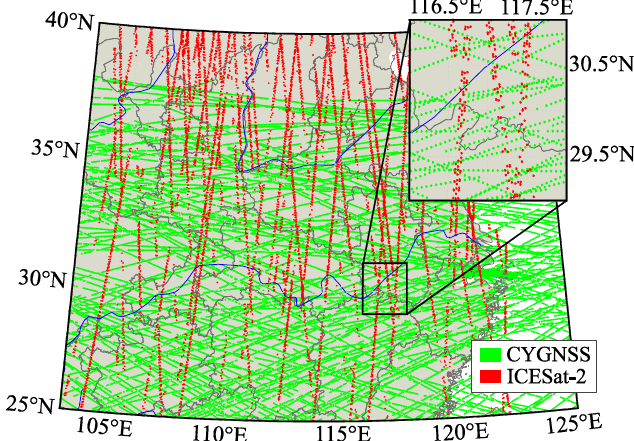
Figure 1. The locations of CYGNSS’s SPs from its eight satellites are plotted in green for 1 April 2019. ICESat-2 data from the whole month of April 2019 is plotted in red. Zoom window shows the spatial resolution in more detail.